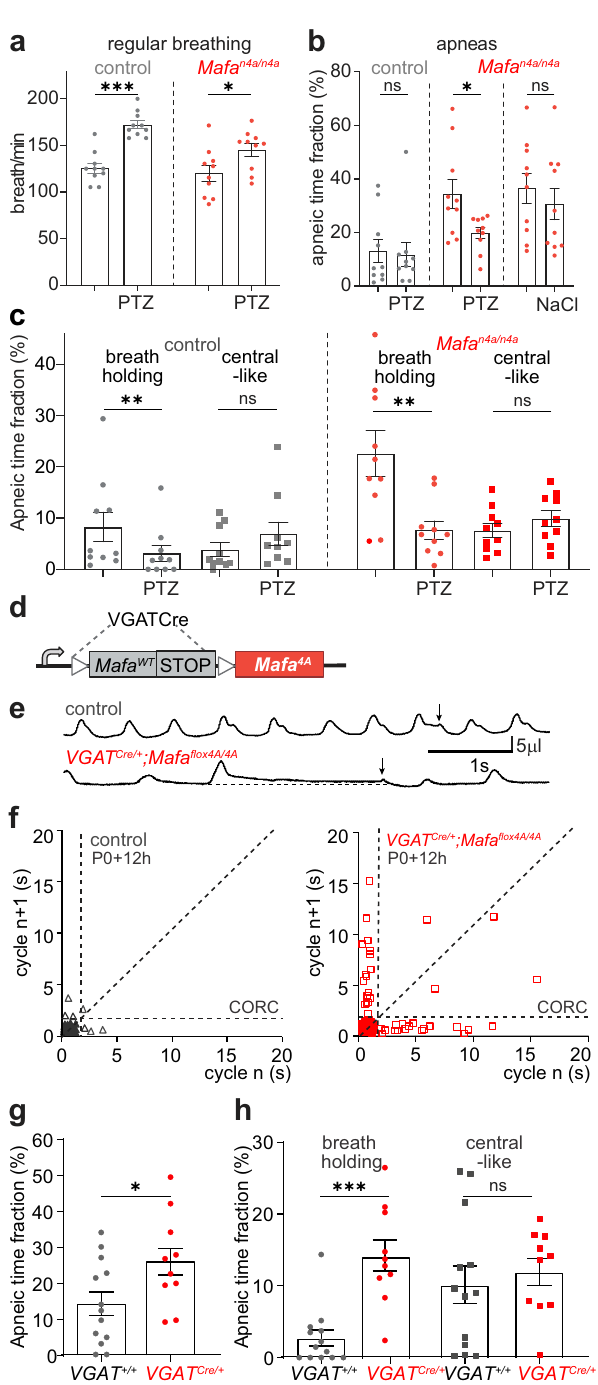
in the dorsal part of the intermediate reticular formation in overlap with the peri12 group of Mafa + inhibitory neurons (Fig. 4f). There, we found that Mafa + /mCherry + virally labeled geniohyoid premotor neurons (Fig. 4g, h) accounted for 10.0 ± 0.4% of all geniohyoid premotor neurons of the peri12 area (counted from 1123 mCherry + /GFP − labeled neurons in 4 pups). These data reveal the existence of a Mafa + inhibitory premotor neuronal subset in a position to depress the motor drive of the geniohyoid muscles, thus facilitate the collapse of upper airways. We next sought the mechanism whereby Mafa expres- breath sion could increase inhibitory neuronal activity. holding ns ✱ Mafa-4A mutation does not alter neuronal development . As Mafa is expressed early in neural progenitors 28 , we investigated the possibility that Mafa mutations may interfere with the development of inhibitory neurons. Focusing on neurons of the medulla which form an exclusive Mafa + inhibitory population we have compared their number across the different Mafa mutant genotypes at P0 (Supplementary Fig. 5). Since the Mafa protein is not detectable by immunostainings in wild type animals, but only in 4A homozygous mutants where the protein is stabilized, we compared therefore searched for Mafa + inhibitory neurons in the circuit ( n = 10 sections, from 2 animals/genotype) the number of Mafa + motorizing an upper airway opener muscle by trans-synaptic viral neurons (immunostained for Mafa) in Mafa 4A/4A to that of tracing 44 . To do this, we injected unilaterally, in Mafa LacZ/ + pups Mafa LacZ/ + , Mafa LacZ/4A and Mafa LacZ/LacZ (immunostained for at P3, a G-defective rabies virus variant encoding the fl uorophore β gal). No signi fi cant differences in the number of Mafa + neurons mCherry together with a helper virus encoding G and the were detected between the different genotypes. These data indicate fl uorophore YFP in the geniohyoid muscle (i.e., that pulls the that Mafa affects neither the proliferation, nor the survival or the hyoid bone forward to increase airway patency) (Fig. 4e) and migration of inhibitory neurons in which it is expressed but, leave examined their brains on P9. As expected, the only seed neurons (i.e., that co-express both fl uorophores) were found in the accessory hypoglossal motor nucleus 45 while the bulk of premotor neurons, presynaptic to the seed motoneurons (i.e., that express only the rabies virus encoded mCherry) was located regulate GABAergic transmission is by controlling GABA NATURE COMMUNICATIONS| (2022) 13:3284